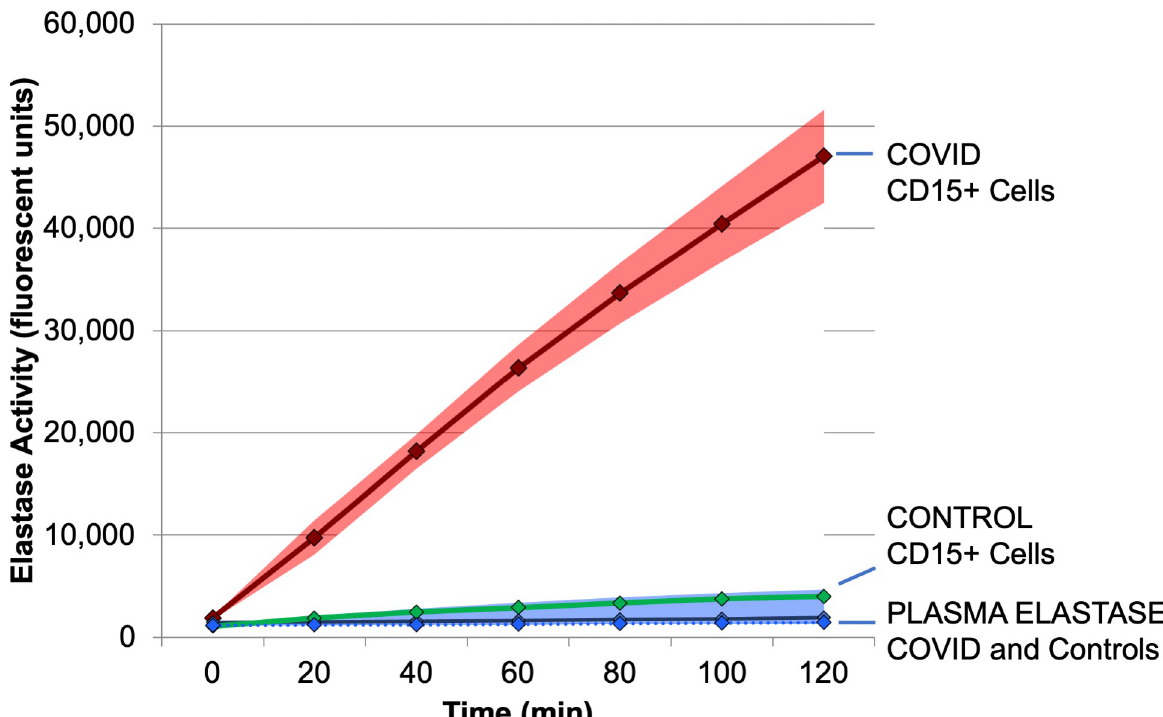
Fig 9. Neutrophil elastase activity of purified CD15+ neutrophils vs. autologous plasma from control or COVID-19 patients. Elastase activity, in relative fluorescence units (Y Axis) was measured in freeze-thaw lysates of purified CD15+ neutrophils from COVID-19 patients (n = 5, RED line) versus plasma (n = 5, BLUE solid line) from the same patients. Points reflect the mean fluorescence (Y axis) at each time point (X axis) with 95% confidence intervals in light red or blue shading. For reference, elastase active from CD15+ neutrophils (GREEN) or plasma (BLUE dashed) of normal controls (n = 3). Plasma elastase from COVID-19 and Controls are low and nearly